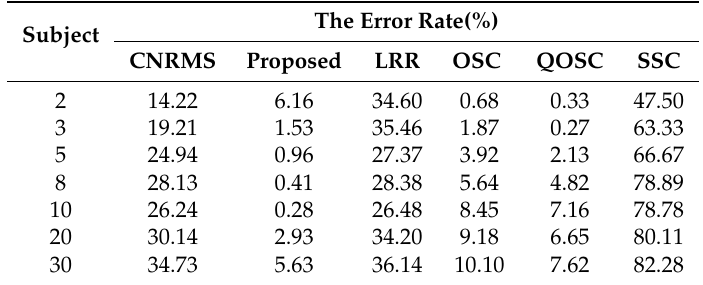
Table 1. Face clustering error rate (%) on the BU-4DFE dataset for 2,3,5,8,10,20,30 subject classes.